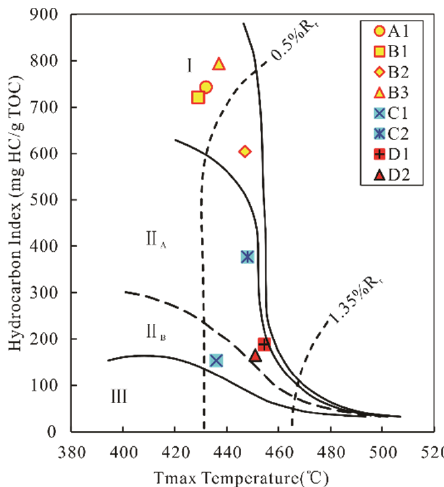
Figure 3. The relationship between the maximum pyrolysis temperature of the source rocks and the hydrogen index (HI) in the study area.